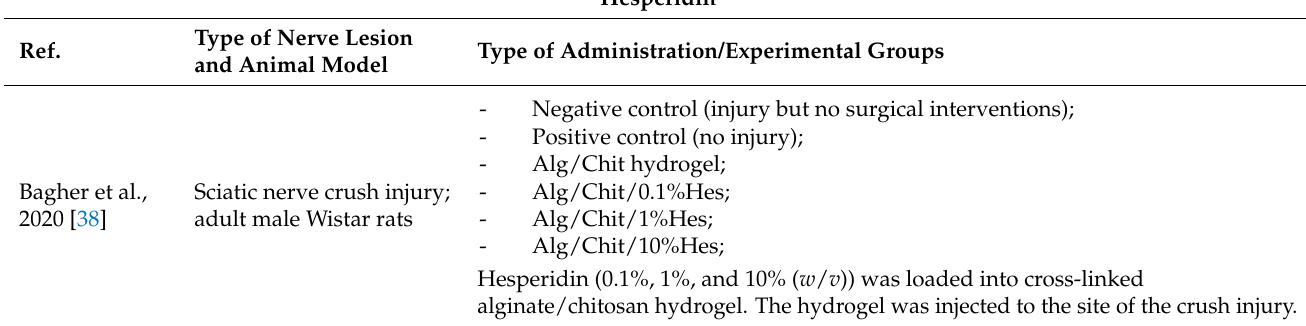
Table 2. Flavanones: Table showing the experimental method (type of nerve injury and animal model), the dose, and the method of administration of hesperidin (Hes) and naringenin. Alg/Chit— Alginate/Chitosan. Included references are listed ascending in accordance to their publication